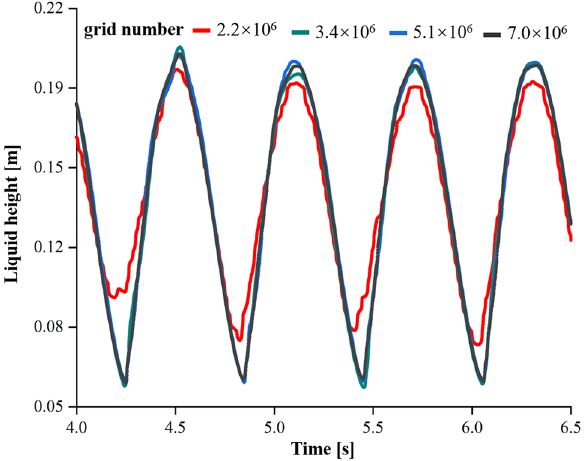
Figure 2. The hollow OSRs of the h L = 0 mm with filling volume of 8 L and shaking speed of 100 rpm was simulated. The simulation of the hollow OSR used the mesh numbers of 2.2 7.0 10 6 to verify the independence of the mesh numbers. In order to obtain the shaking of liquid height with × time, the liquid height was automatically saved every 30 time-steps (0.0001 s) during the simulation process. The height of the liquid at the interface was measured at the point of intersection with the fixed vertical line on the vessel